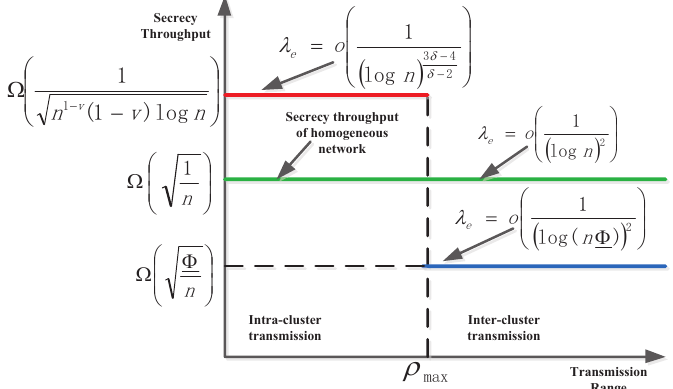
Figure 6. An illustration of secrecy throughput. We also give a comparison with that in a homogeneous networks